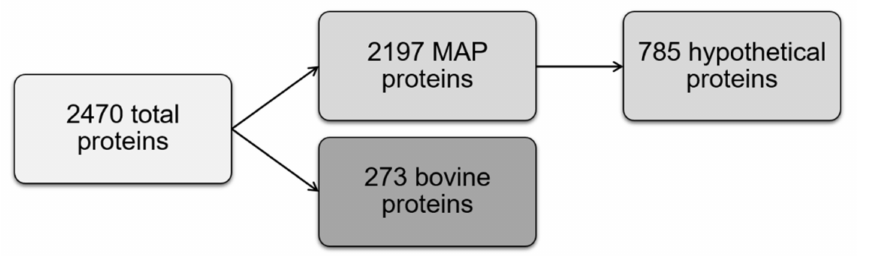
Figure 1. Overview of identified proteins. Of the total of 2470 proteins identified, 237 were classified as bovine and 2197 were linked to MAP. Furthermore, 785 of identified MAP proteins were previously not described on a proteomic level and therefore thus far classified as hypothetical proteins.